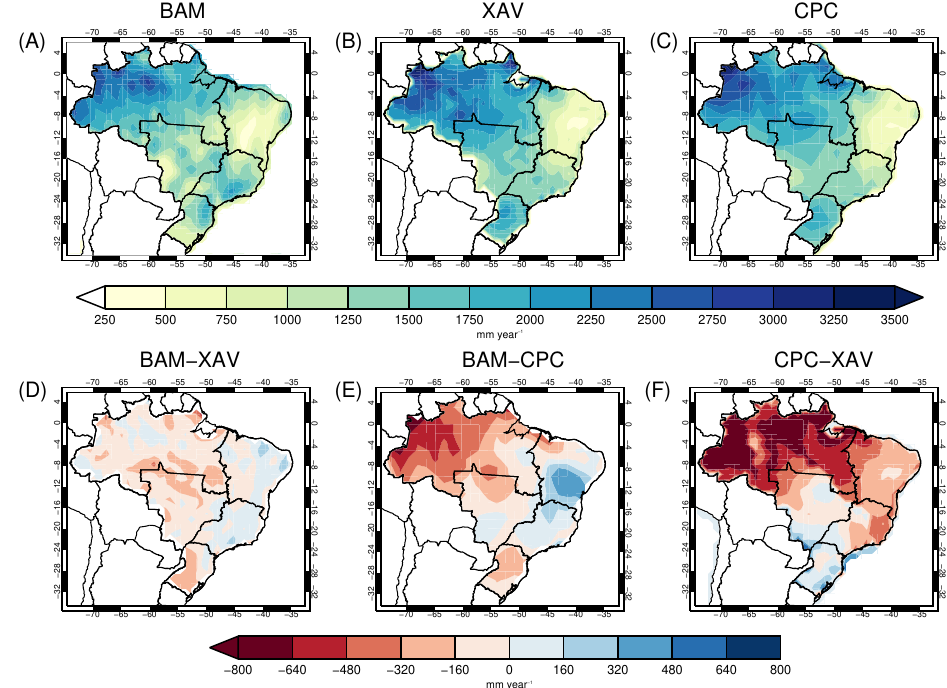
Figure 2. Mean annual precipitation (mm year − 1 ) (1990–2015) from the BAM ( A ), XAV ( B ), and CPC ( C ) (upper panel). Mean annual precipitation difference between the BAM and XAV ( D ), between the BAM and CPC ( E ), and between the CPC and XAV ( F ) (lower